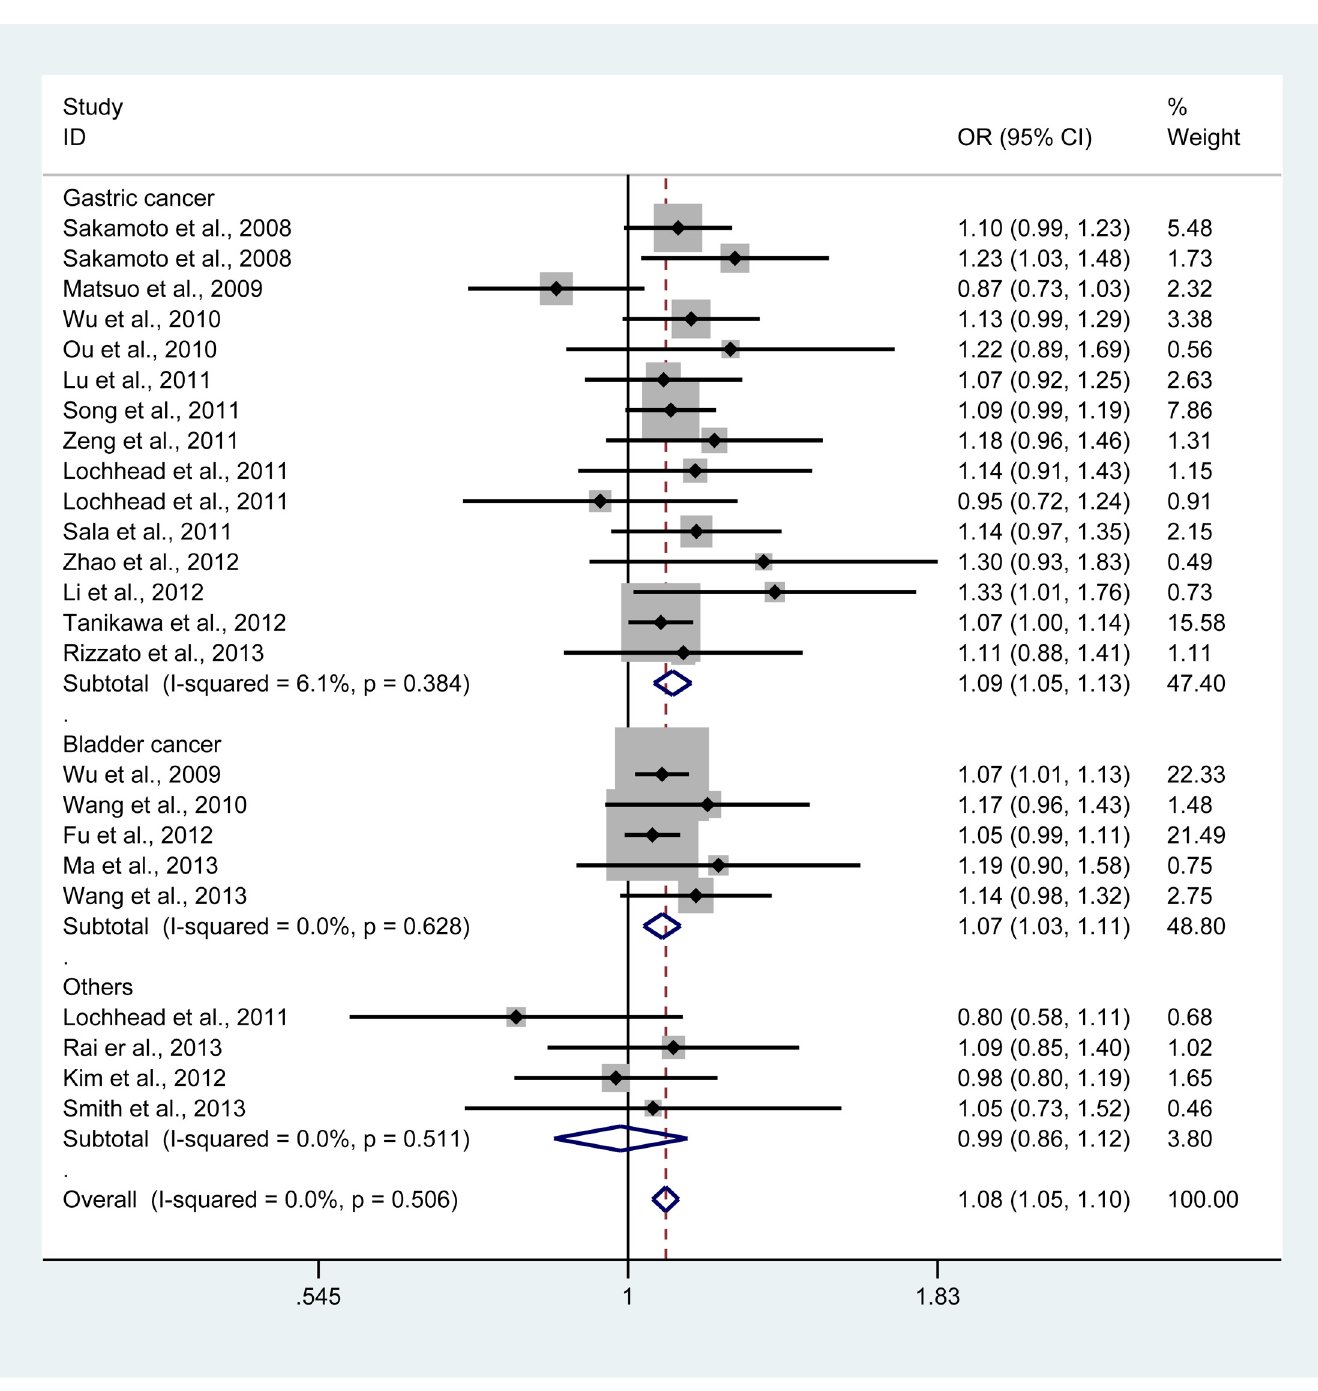
Fig 3. Forest plot of cancer susceptibility associated with PSCA rs2294008 polymorphism under TT + CT vs CC stratified according to cancer type. For each study, the estimates of OR and its 95% CI were plotted with a box and a horizontal line. The symbol filled diamond indicates pooled OR and its 95% CI. Fixed effects meta-analysis shows a significant